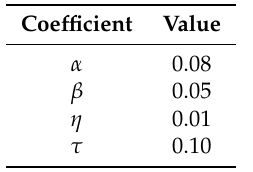
Table 2. Tables of the employed coefficients for setting the level of filtering in the proposed